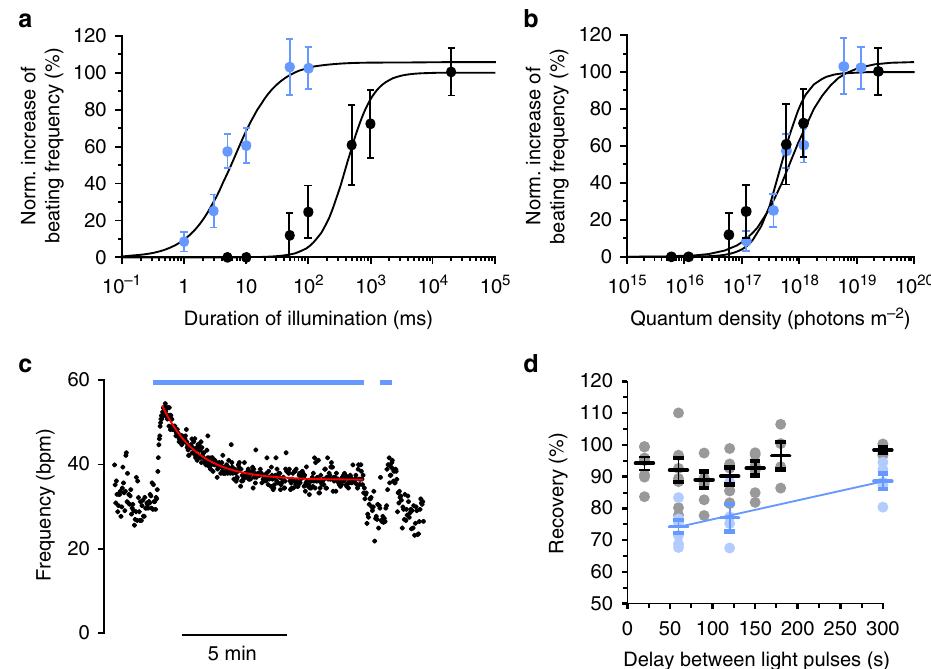
Fig. 3 Analysis of JellyOp light sensitivity and recovery in ESC-derived cardiomyocytes in vitro. a , b Relationship between normalized peak frequency increase and duration of light pulses ( a ) or applied photon-density ( b ) for light pulses with 30.9 (blue dots) and 0.309 (black dots) μ W mm − 2 ( n = 6). c Representative frequency trace with long illumination (blue bar, 309 nW mm − 2 , 10 min, inactivation fi t in red) and a subsequent second light pulse (20 s). d Percentage of recovery of frequency response after a short (20 s, black dots) or a long-lasting (10 min, blue dots) illumination (309 nW mm − 2 ) analyzed with a second light pulse at various delay after the fi rst light pulse. Error bars: